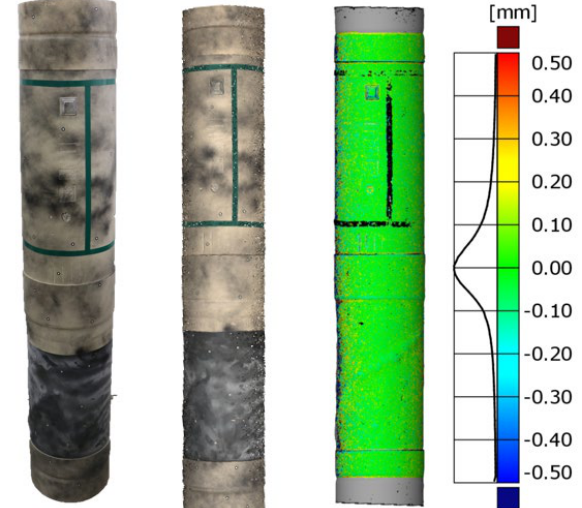
Figure 16. In sequence: photo, 3D textured mesh and deviation map obtained for the practical experiment. Obtained error standard deviation of 0.58